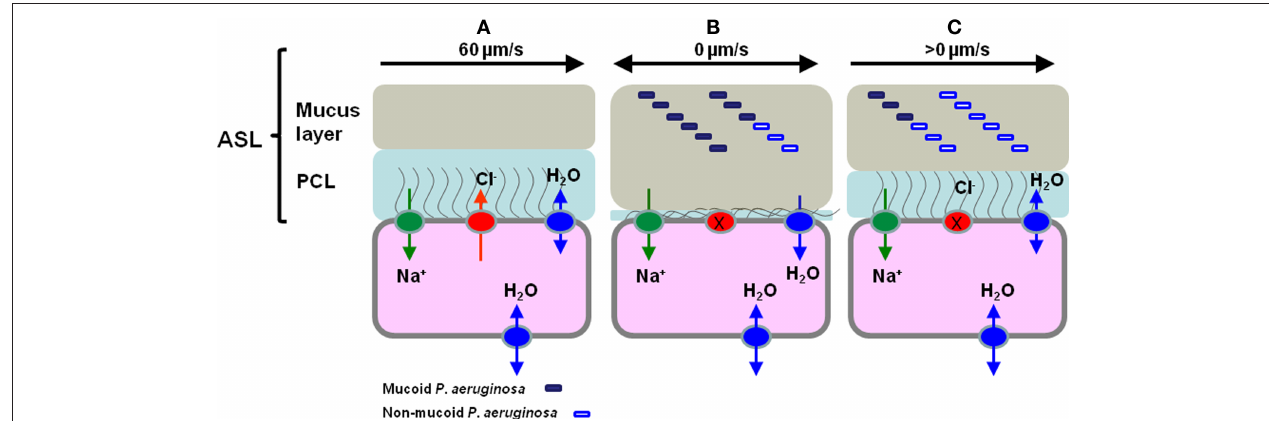
The lack of PCL lubrication means that cilia cannot beat to move mucus out of the lung and this results in chronic bacterial infection indicated here by non-mucoid (open rectangle) and mucoid (filled rectangle) P. aeruginosa. (C) Following HS treatment it is proposed that ASL volume increases as it encourages transmembrane water movement and that this leads to a partial rehydration of the PCL and less sticky, partially rehydrated mucus and the possibility of some cilial beating-mediated mucus clearance. Furthermore, we propose that the increased salinity of the ASL leads to a shift in the P. aeruginosa population as consequence of the osmotic sensitivity of the mucoid P. aeruginosa and that this population shift impacts on the frequency of